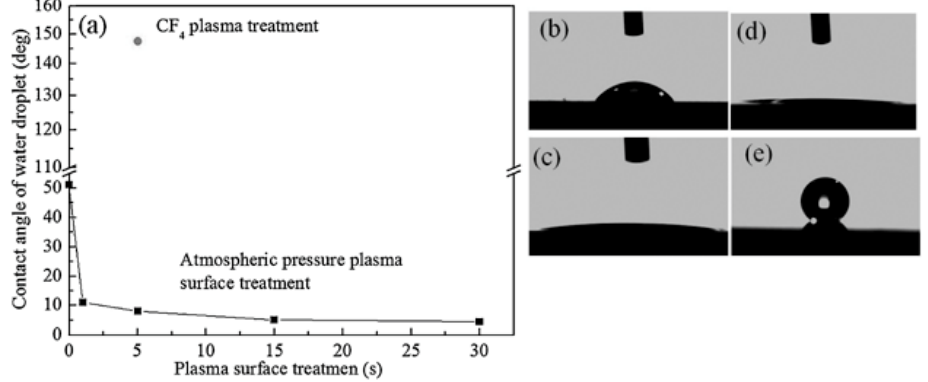
Figure 11. ( a ) Contact angles of water droplets on CNWs as a function of the plasma treatment time, ( b ) as-grown CNWs, ( c ) CNWs after Ar atmospheric pressure plasma treatment for 5 s, ( d ) CNWs after Ar atmospheric pressure of plasma treatment for 30 s, and ( e ) CNWs after CF4 plasma treatment for 5 s. Reproduced with permission from [106]. Copyright John Wiley and Sons 2013.